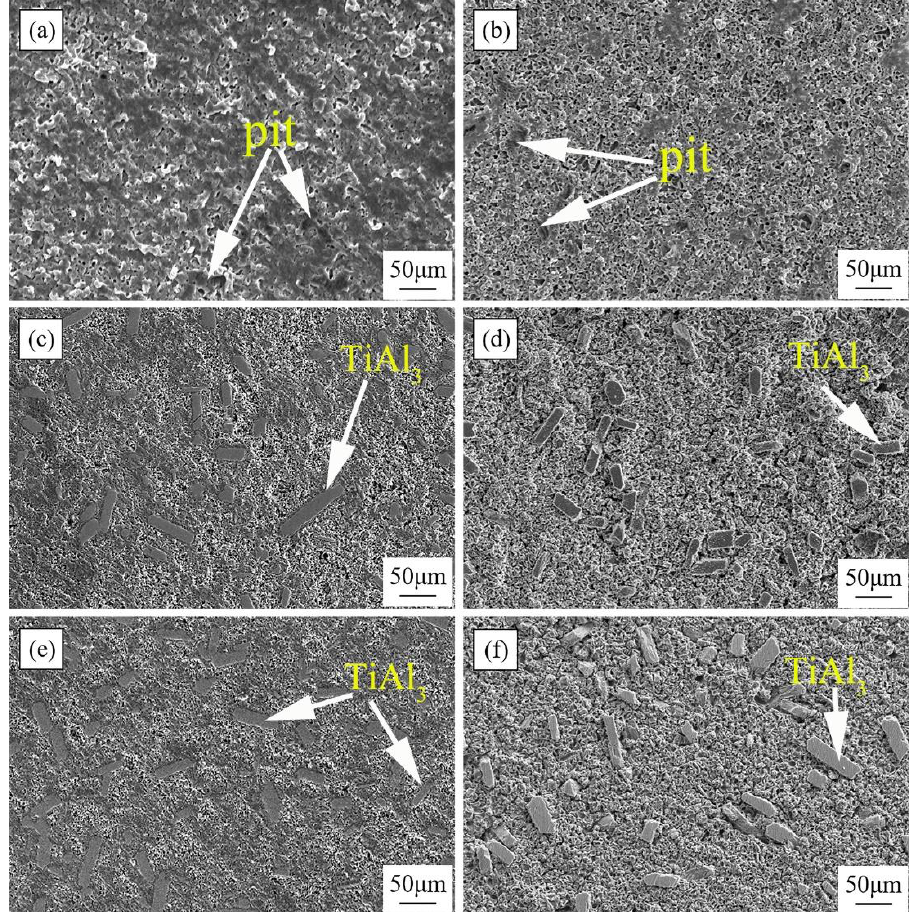
Figure 5. Surface morphologies of Al, Al–5Ti, and Al–10Ti alloys after cavitation erosion for 10 min and 30 min in 3.5 wt.% NaCl solution; ( a , c , e ) are the morphologies of Al, Al–5Ti, and Al–10Ti alloys after cavitation erosion for 10 min, respectively; ( b , d , f ) are the morphologies of Al, Al–5Ti, and Al–10Ti alloys after cavitation erosion for 30 min, respectively.